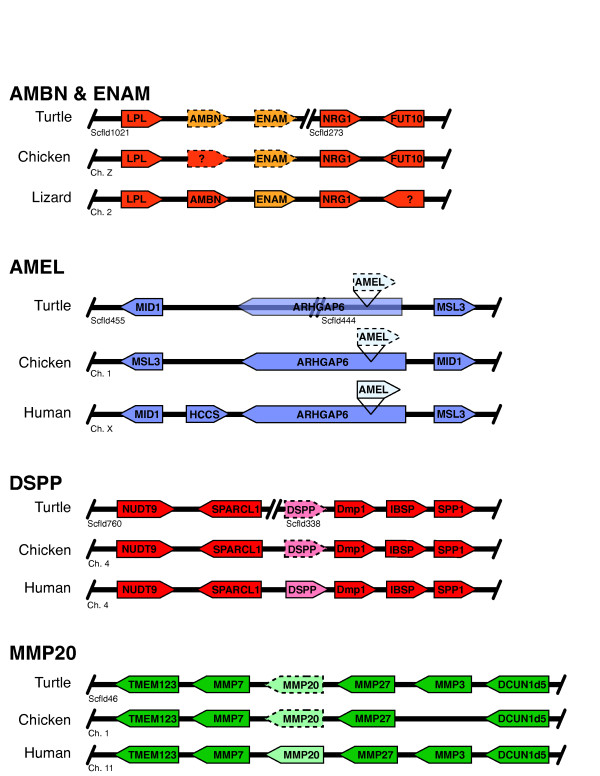
Conserved syntenic regions containing tooth-specific genes across toothed (human, anole) and edentulous (turtle, chicken) vertebrates. AMBN and ENAM are in a reptile-specific chromosomal region, precluding the use of human as a reference sequence for these genes. Dashed outlines indicate pseudogenization.